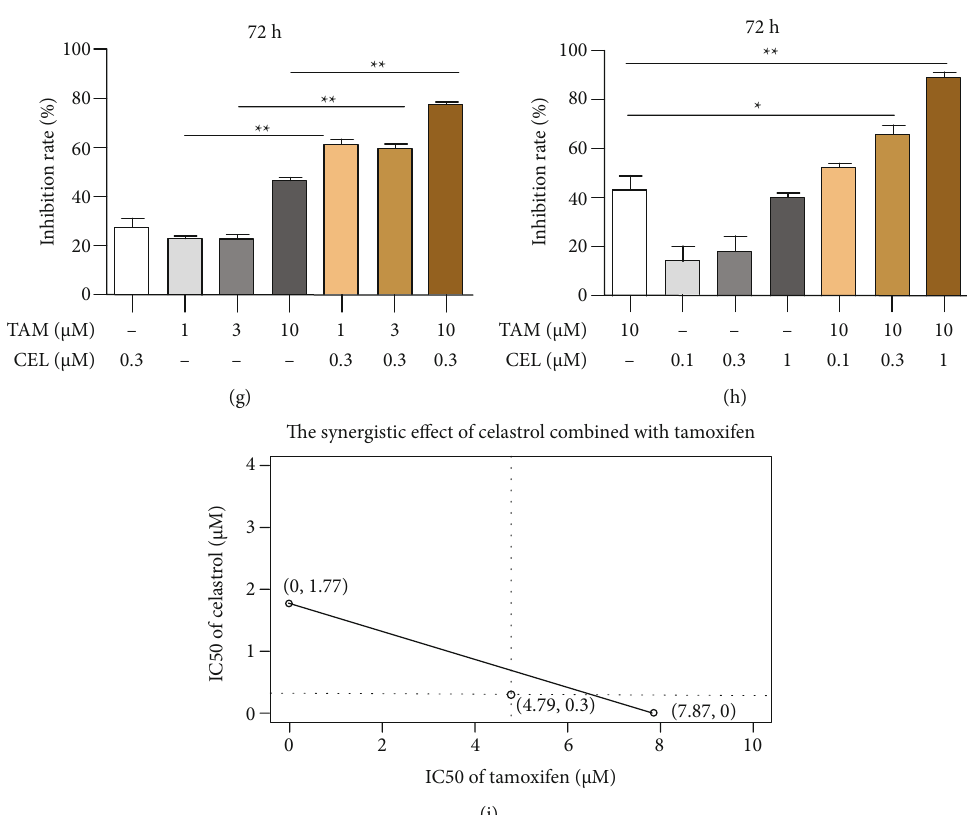
Figure 1: E ff ects on MCF-7 cell inhibition at di ff erent times and with di ff erent doses of TAM, celastrol, and their combination. (a – h) The e ff ects on MCF-7 cell inhibition with di ff erent doses of TAM, celastrol, and their combination at 24h, 48h, and 72h, respectively. (i) The IC50 values of celastrol and tamoxifen on MCF-7 cells were 1.77 and 7.87 μ M at 48h, respectively. The IC50 value of tamoxifen was 4.79 μ M when combined with celxastrol (0.3 μ M). The empty dot below the line indicates a synergistic e ff ect by isobolographic analysis.